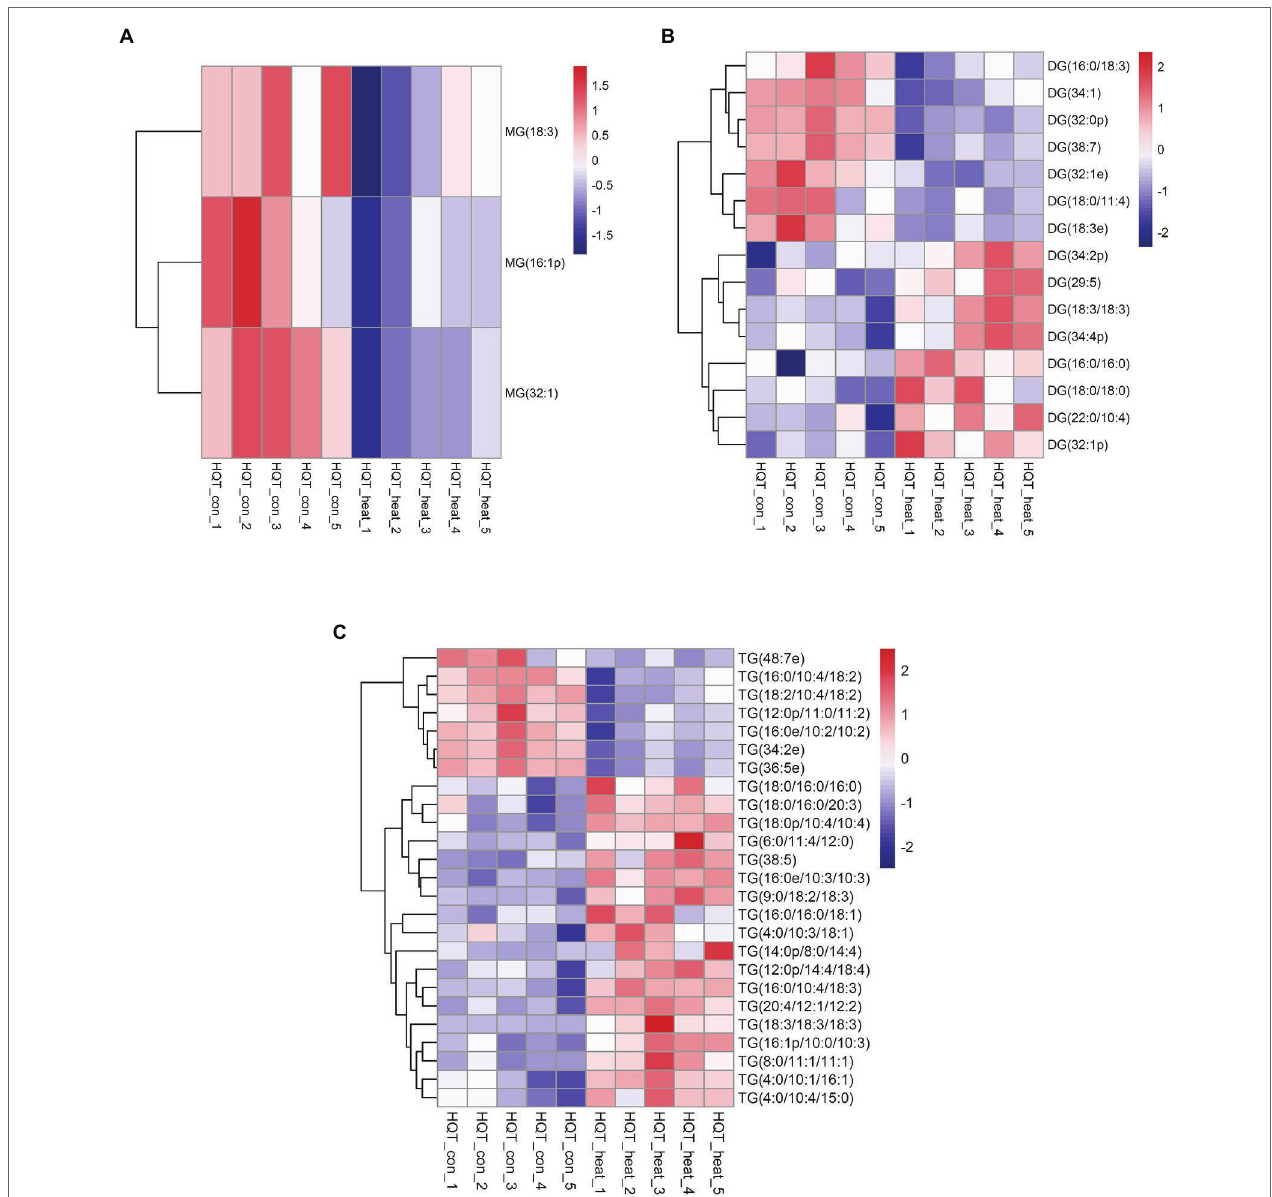
FIGURE 2 | Heat map of profiles for the glycerolipid species identified in leaves of B. grandis under heat stress. Fully extended leaves detached from 173-d-old plants of B. grandis were at control condition (22 ° C for 2 h) or challenged with heat stress (45 ° C for 2 h). Each column represents an LC–MS measurement from five biological replicates of control condition (HQT_con_1 to HQT_con_5) or five biological replicates of heat treatment (HQT_heat_1 to HQT_heat_5). The glycerolipid species of (A) monoacylglycerol (MG), (B) diacylglycerol (DG), and (C) triacylglycerol (TG) measured from the control and heat treatment conditions were